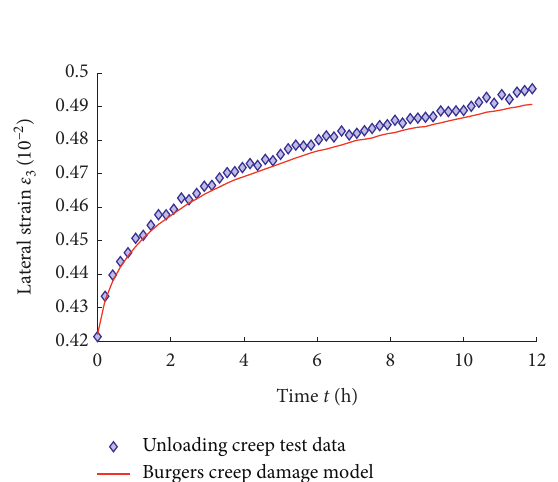
Figure 15: Burgers fitting curve of constant axial pressure unloading of confining